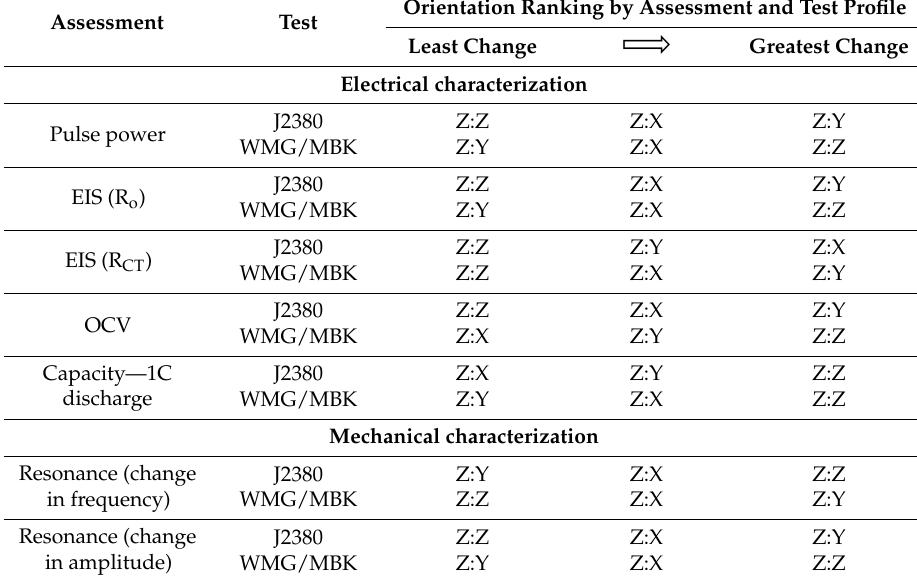
Table 7. Assessment ranking of orientation by test.